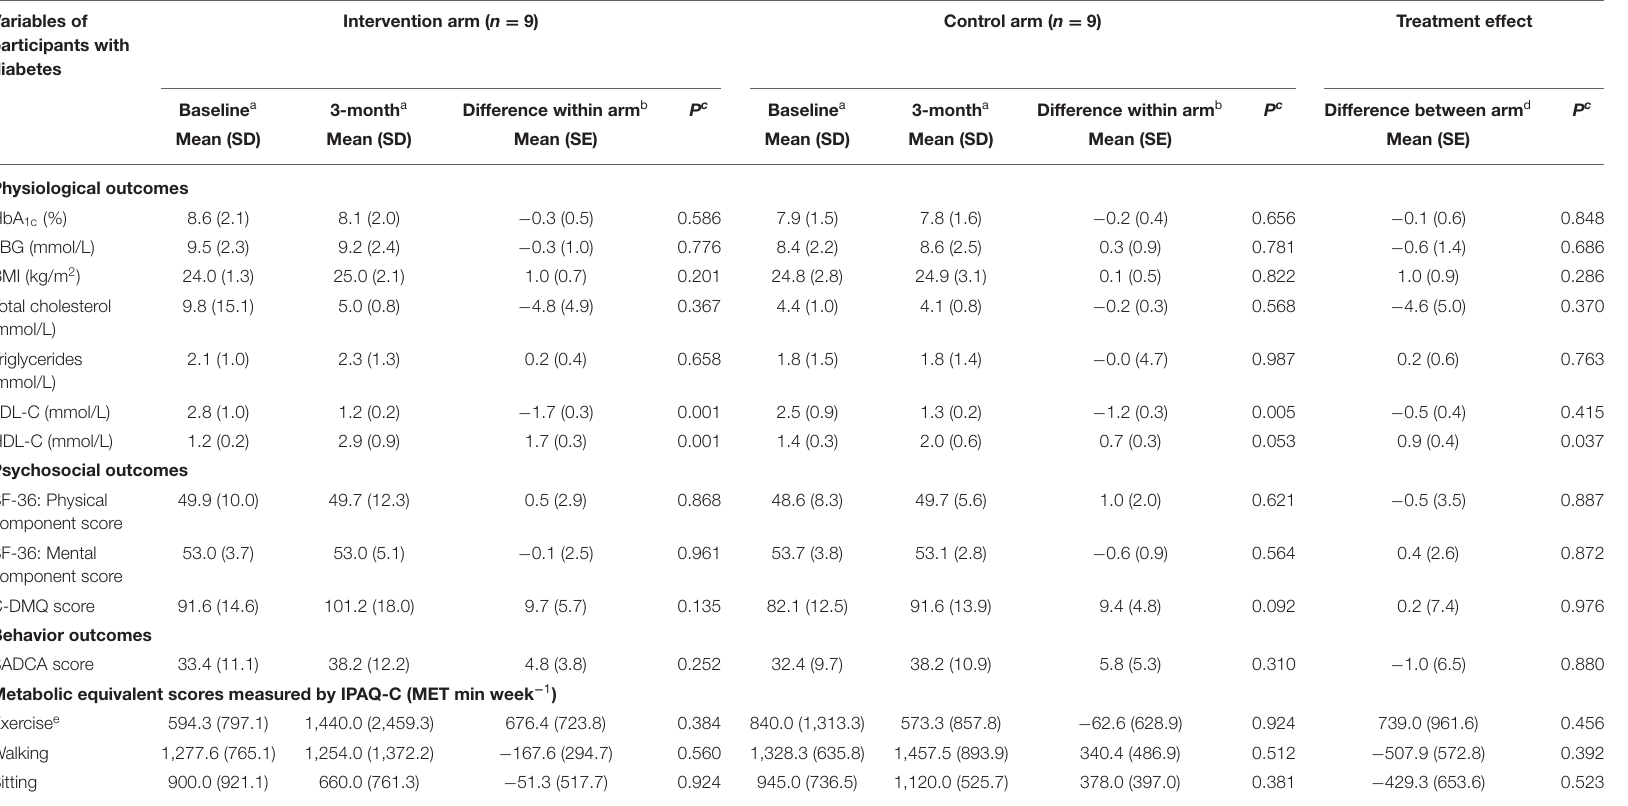
TABLE 2 | Treatment effects of couple-based interventions on participants with diabetes of the 3-month pilot study (couple pair N = 18). Variables of participants